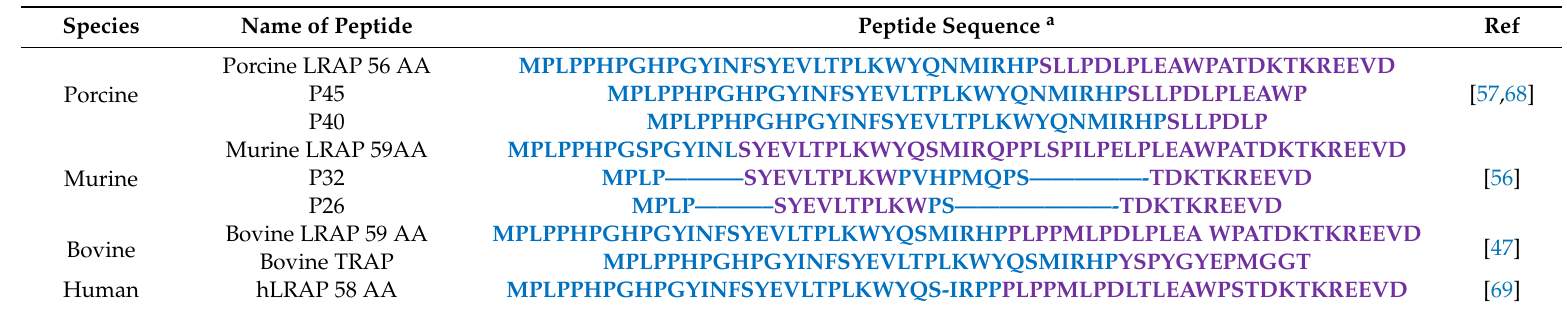
Table 2. Rationally designed peptides derived from native amelogenin protein to form potential mineral regeneration